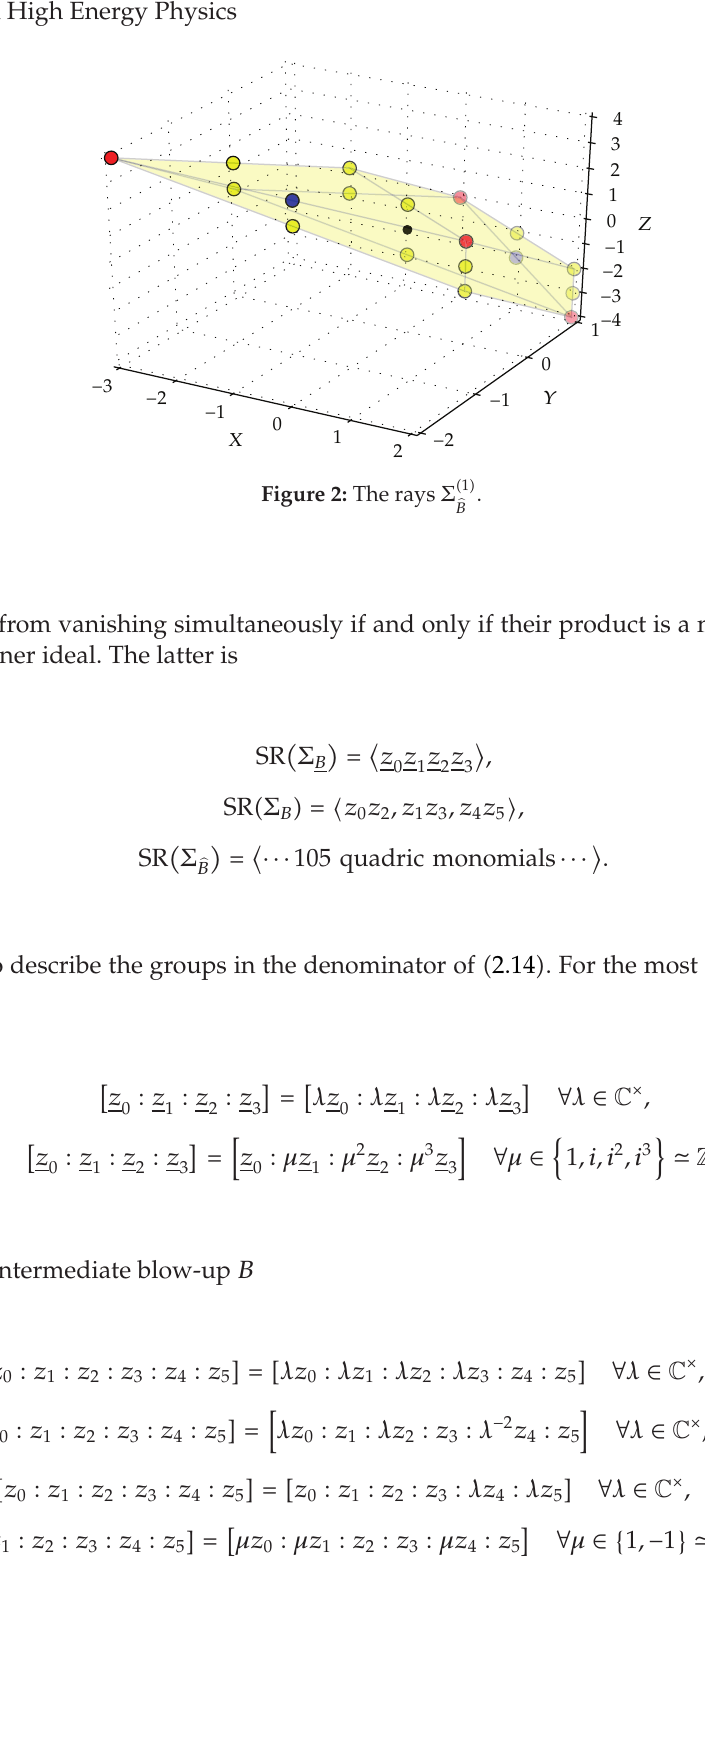
(cid:2) 1 (cid:3) (cid:16) B